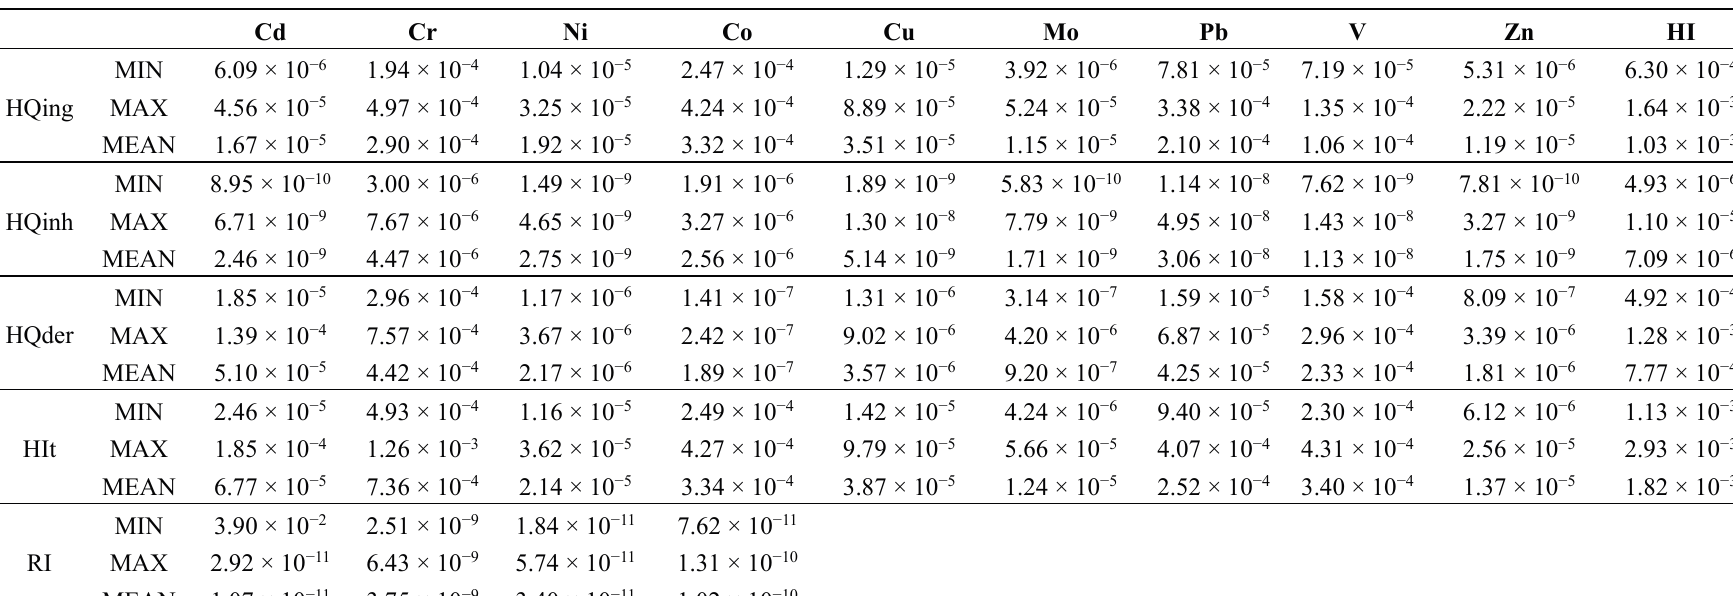
Table 5. Health risks from heavy metals in